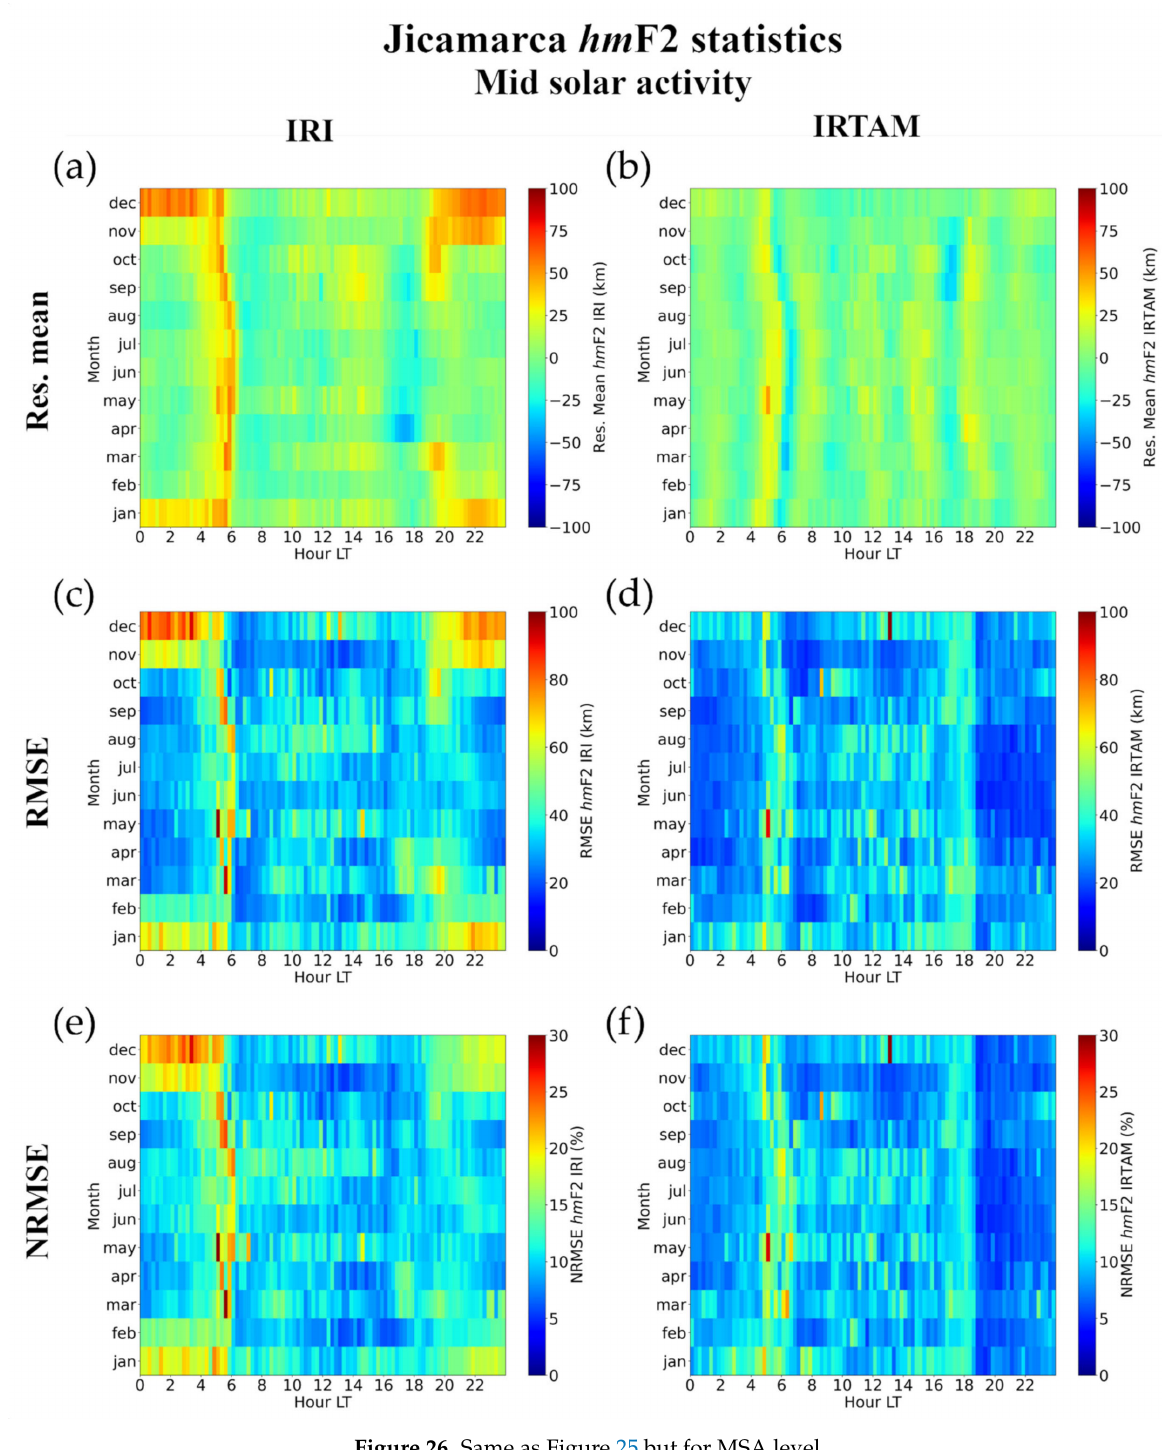
Figure 26. Same as Figure 25 but for MSA